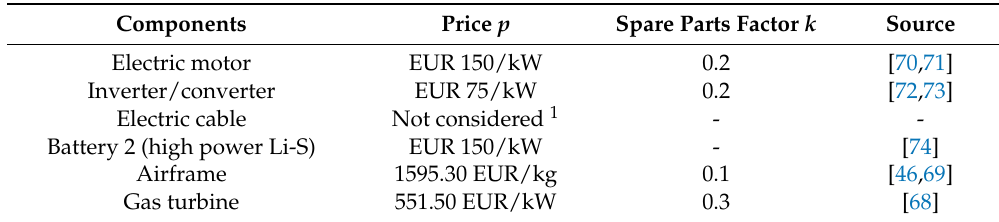
Table A1. Overview of component prices and spare parts factors. Components Price p Spare Parts Factor